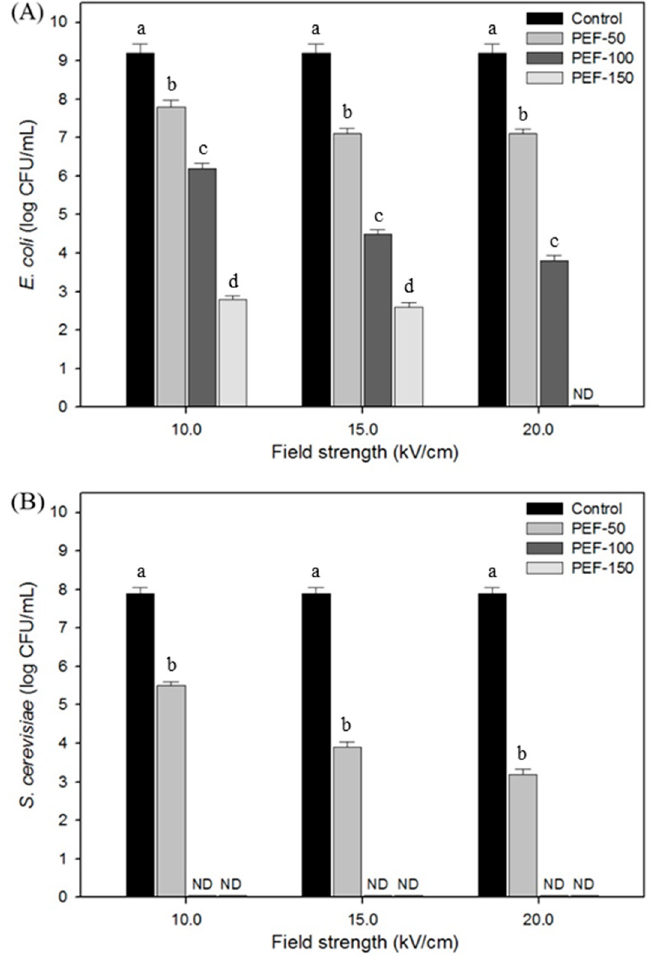
Figure 1. The inactivation of ( A ) Escherichia coli and ( B ) Saccharomyces cerevisiae inoculated in sterilized orange juice by pulsed electric field (PEF) treatments. PEF treatments were conducted at a field strength of 10, 15, and 20 kV/cm with different pulse frequencies, which resulted in PEF total specific energy inputs of 50 kJ/L (PEF-50), 100 kJ/L (PEF-100), and 150 kJ/L (PEF-150). ND, not de- tected.